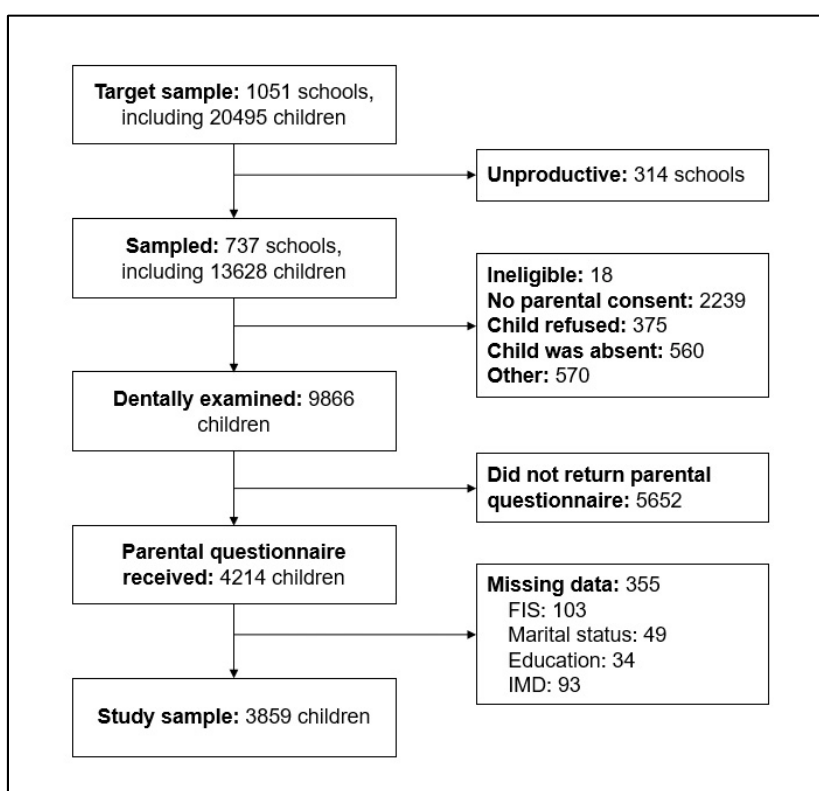
Figure 1. Participation at different stages of the 2013 Children’s Dental Health Survey. FIS: Family impact scale. IMD: index of multiple deprivation.